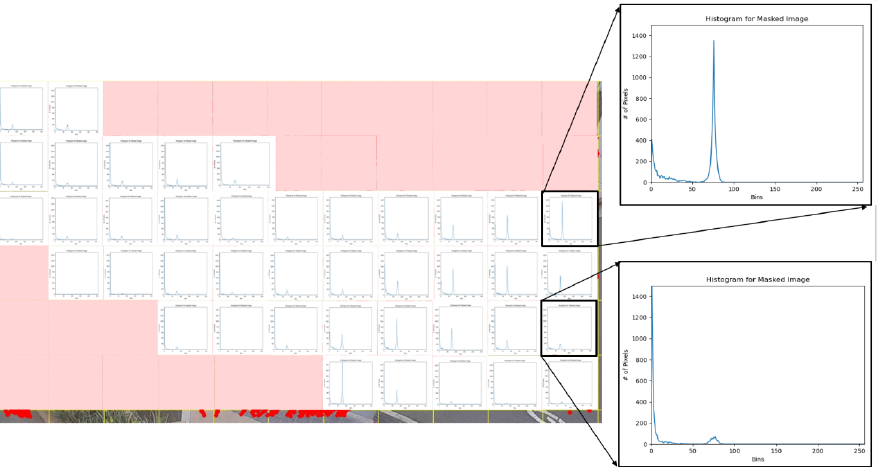
Figure 34. Histogram calculated for selected grids. This figure shows two cases where a grid cell yields a high peak representing a high density of streamlines, and another cell with a low peak indicating lower streamline density.